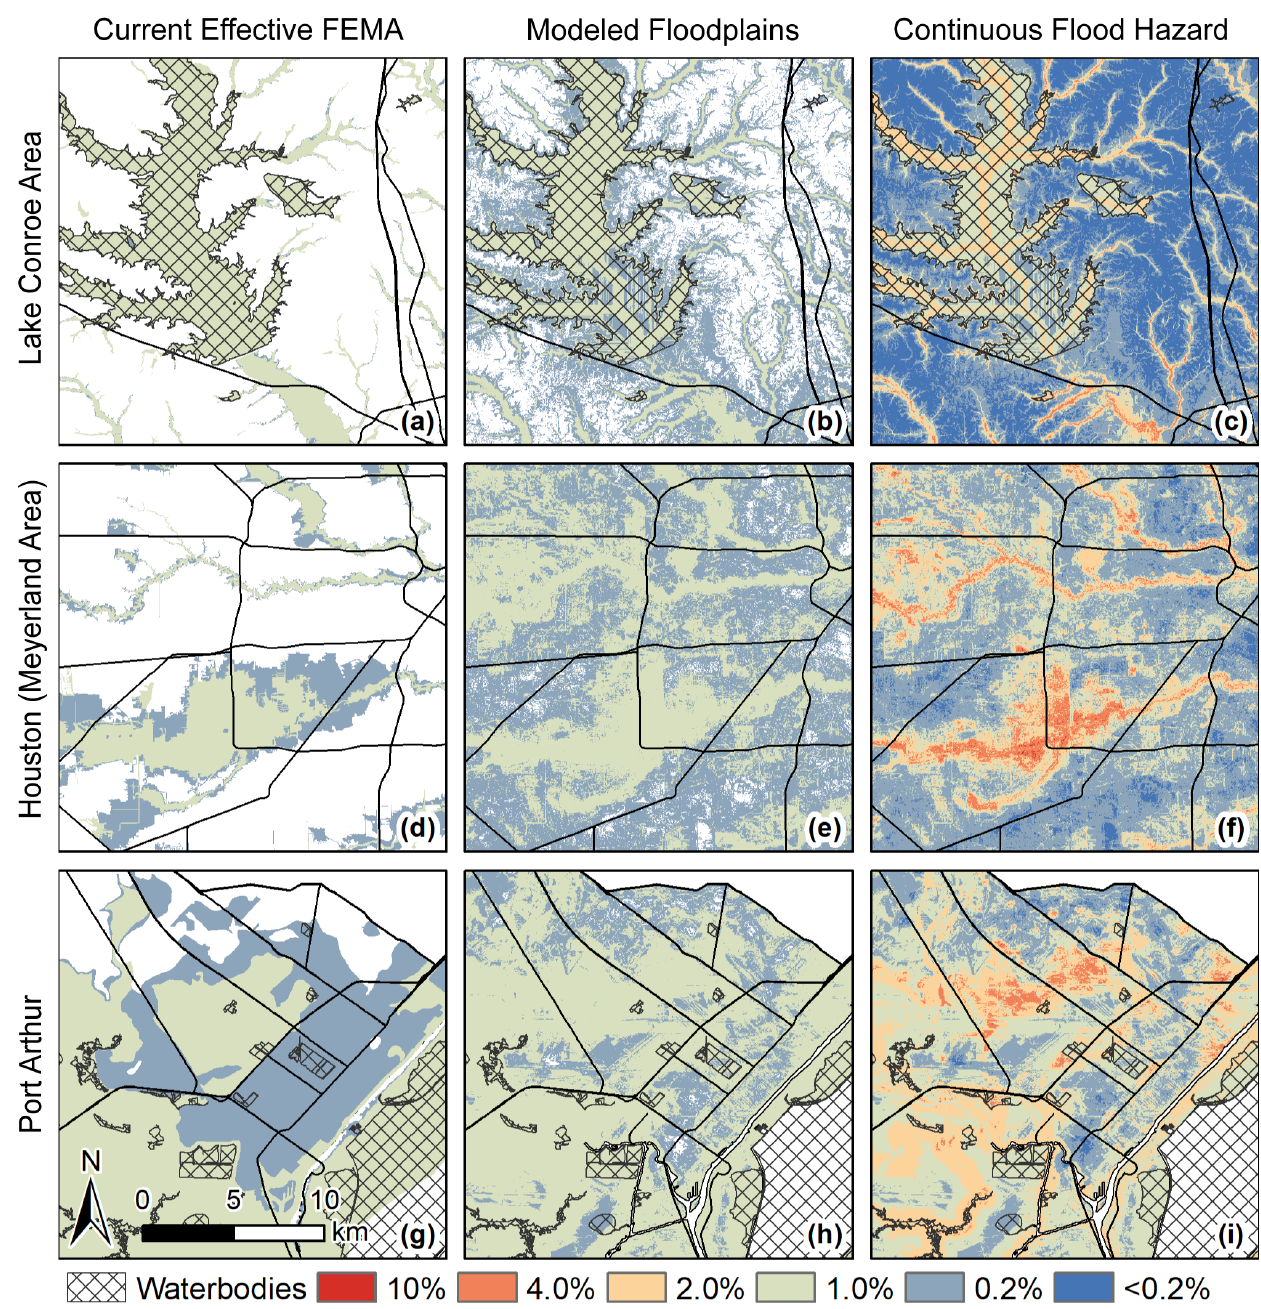
Figure 7. Side-by-side visual comparison for three areas affected by differing flood types. (a–c) Lake Conroe Area, (d–f) Houston (Meyerland Area), and (g–i) Port Arthur. Maps compare (a, d, g) current effective 100- and 500-year FEMA SFHA (ca. 2016), (b, e, h) areas within the 1% and 0.2% annual flood zones based on the random forest estimate, and (c, f, i) continuous flood hazard map. Road layers originated from the US Census Bureau, and floodplains originated from the Federal Emergency Management